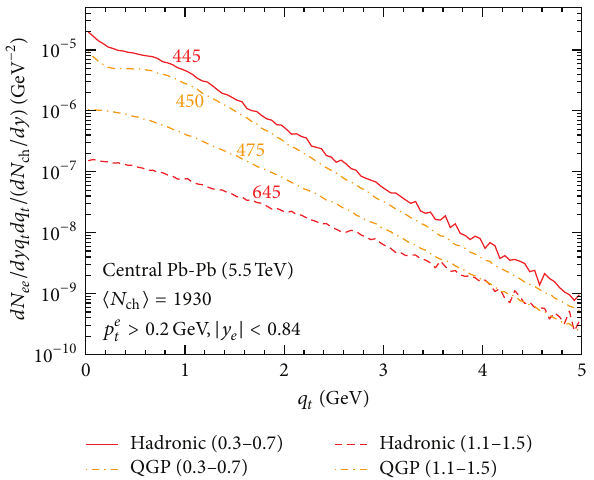
Figure 12: Same as Figure 6, but for central Pb-Pb(5.5ATeV).